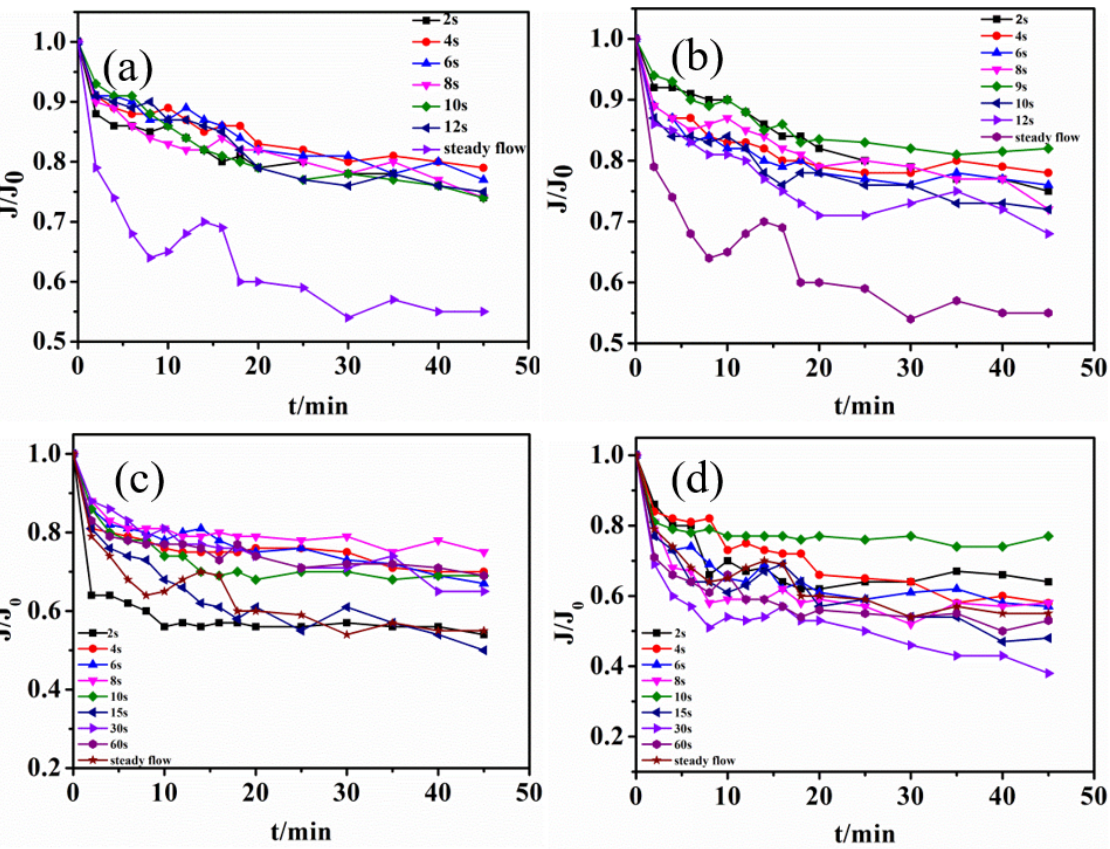
Figure 4. Membrane-specific flux–time diagrams of different function feeding modes ( a ) square wave, ( b ) sine, ( c ) reciprocal, and ( d ) power